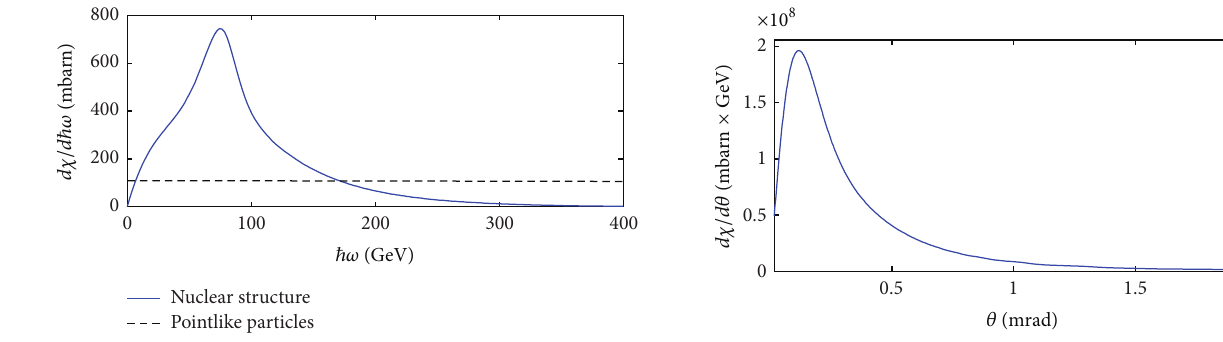
Figure 3: The angular distribution of bremsstrahlung from a Pb-208 projectile with energy 7 TeV × 𝑍 incident on a lead target. Note that the cross section is shown to be differential in the polar emission angle 𝜃 rather than in solid angle and hence includes a factor of 2 𝜋 sin (𝜃) . The majority of the bremsstrahlung photons are indeed emitted in the very near forward